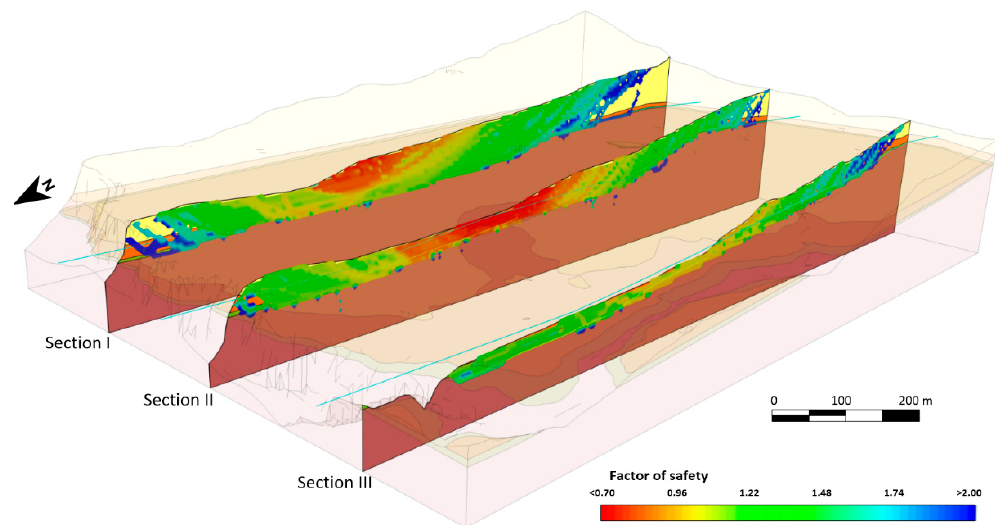
Figure 8. Factor of safety variation along the sliding materials of three different cross-sections.